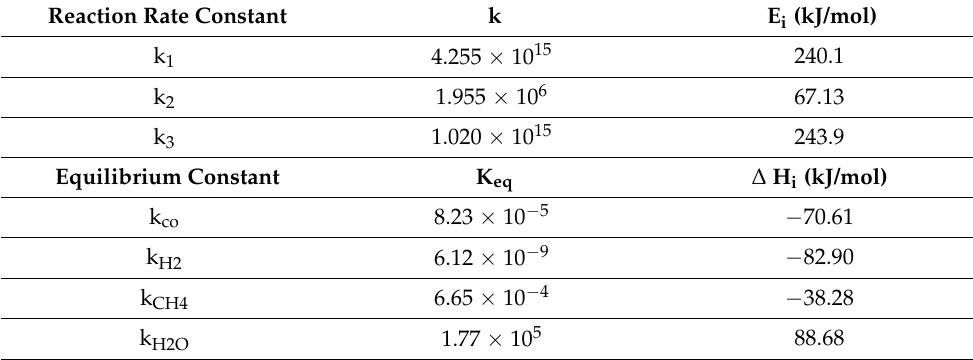
Table A5. Parameters of methane steam reforming [21].